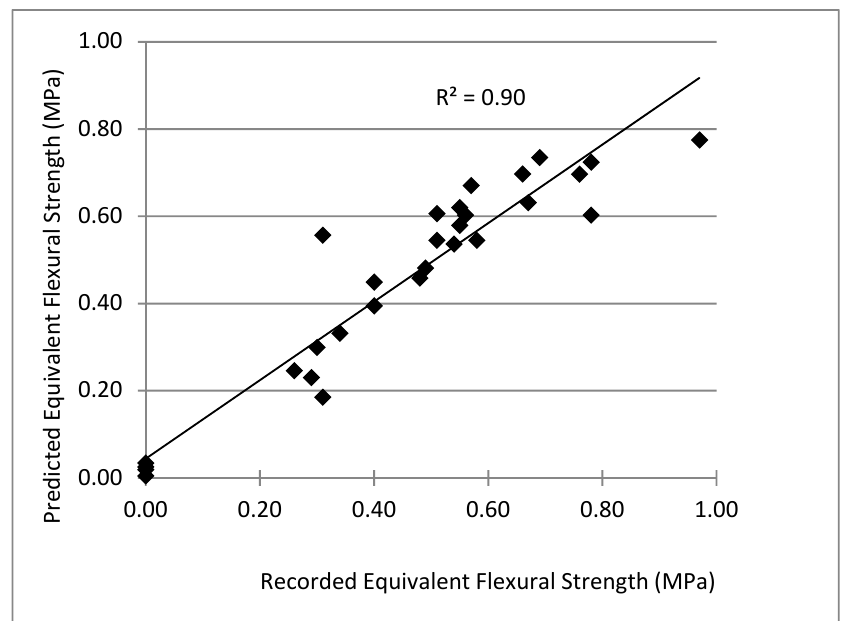
Figure 6. Predicted vs. experimentally recorded equivalent flexural strength (n =30). Table 9. Model summary .